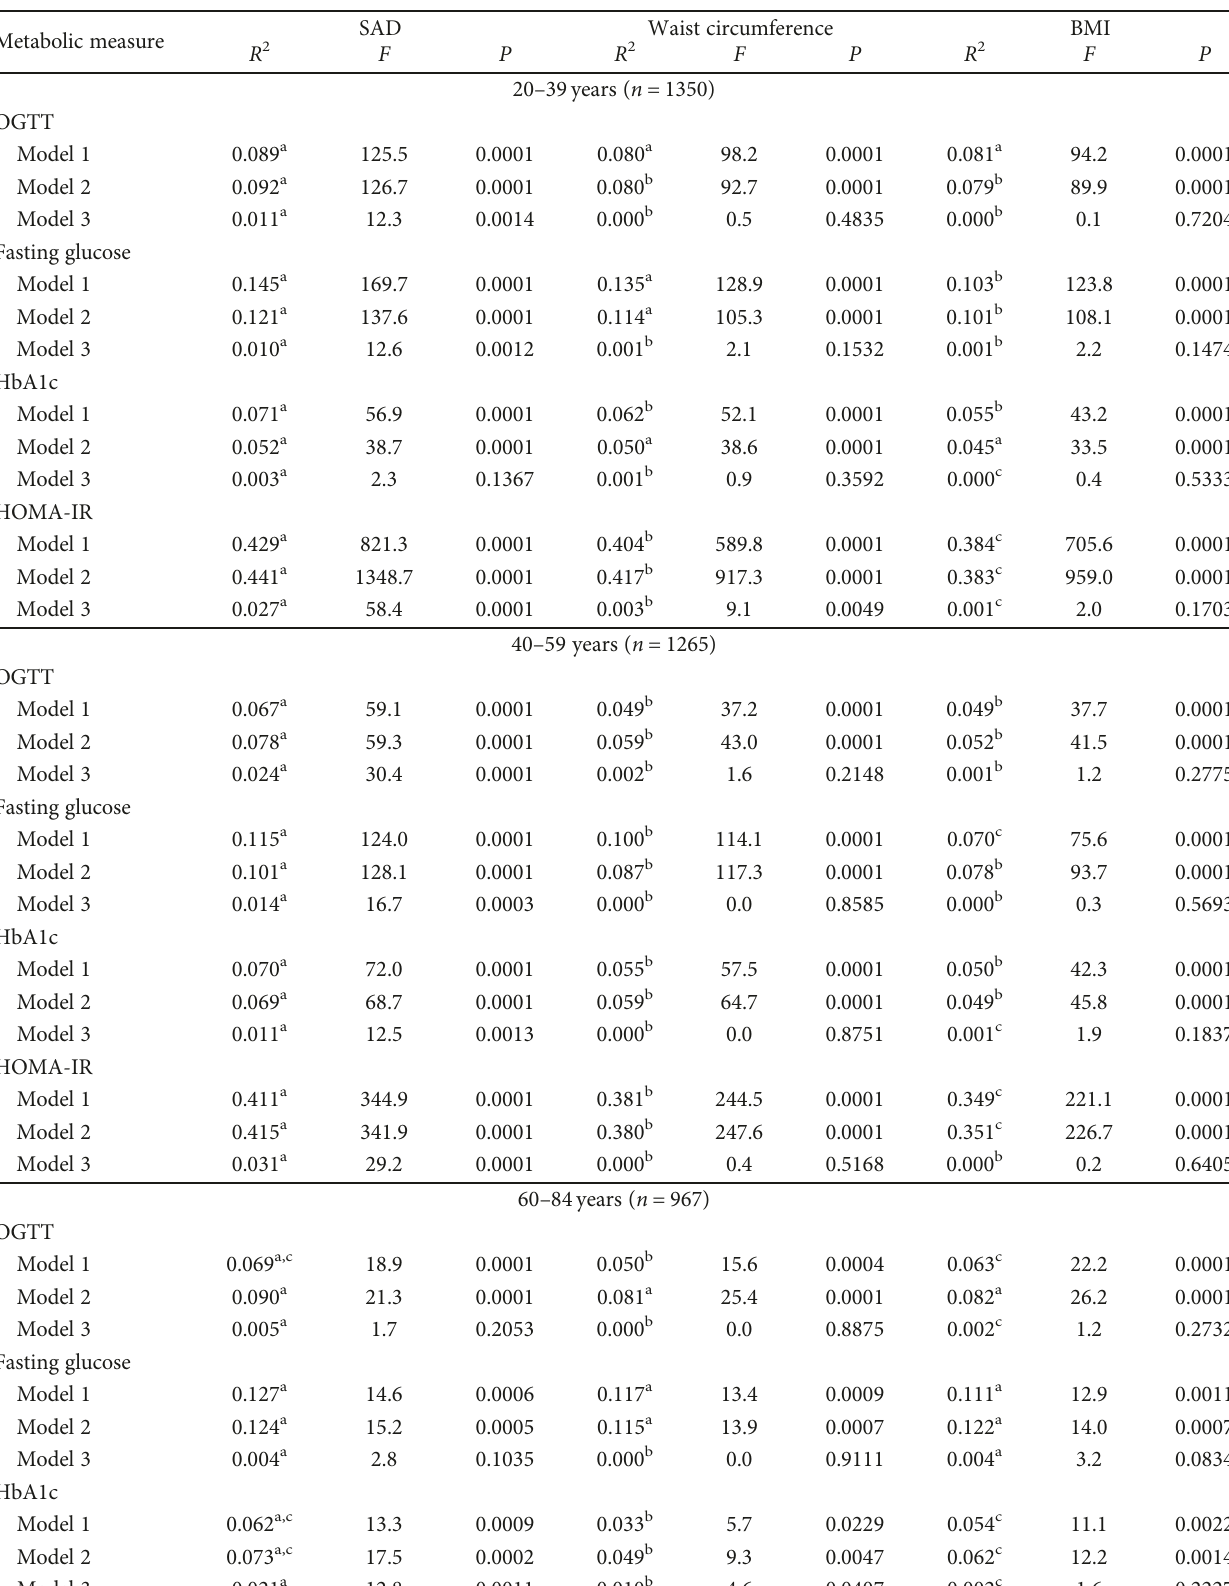
Table 6: Shared variance between the anthropometric variables and the glucose metabolism variables by age category. Metabolic measure